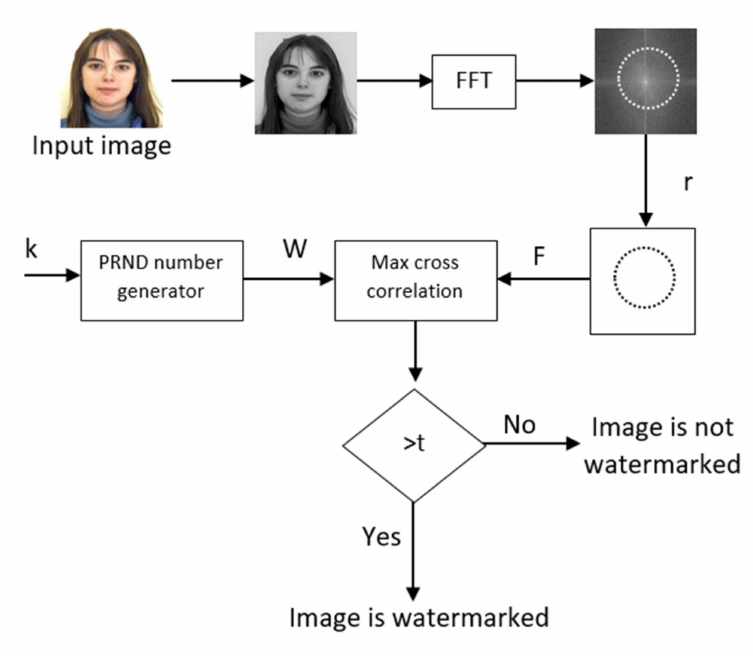
Figure 3. Fourier watermark detection